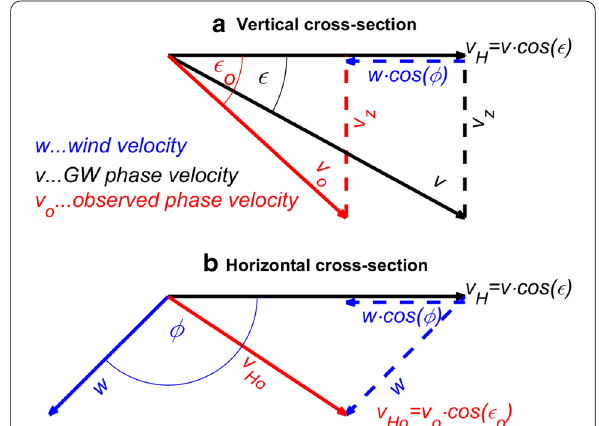
Fig. 1 Relations between the observed velocity v o (red), wind-rest frame velocity v (black), including their horizontal and vertical components, and horizontal wind velocity w (blue). a vertical cross-section (projection to the vertical plane of v ), b horizontal